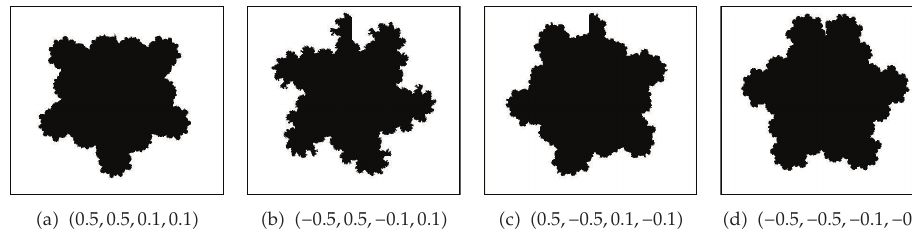
Figure 15: The generalized J sets perturbed by multiplicative noise when α (cid:6) 5 . 5, θ ∈ (cid:7) − π/ 2 , 3 π/ 2 (cid:4)